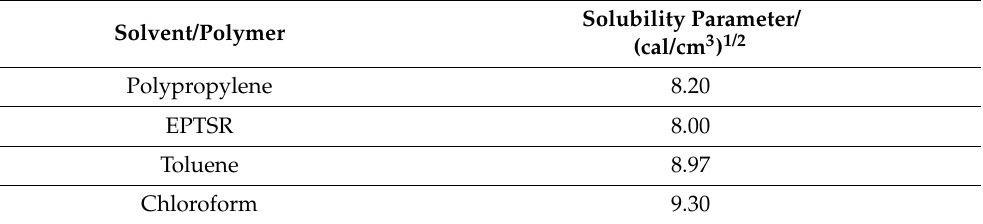
Table 2. Solubility parameters of polymers and solvents.